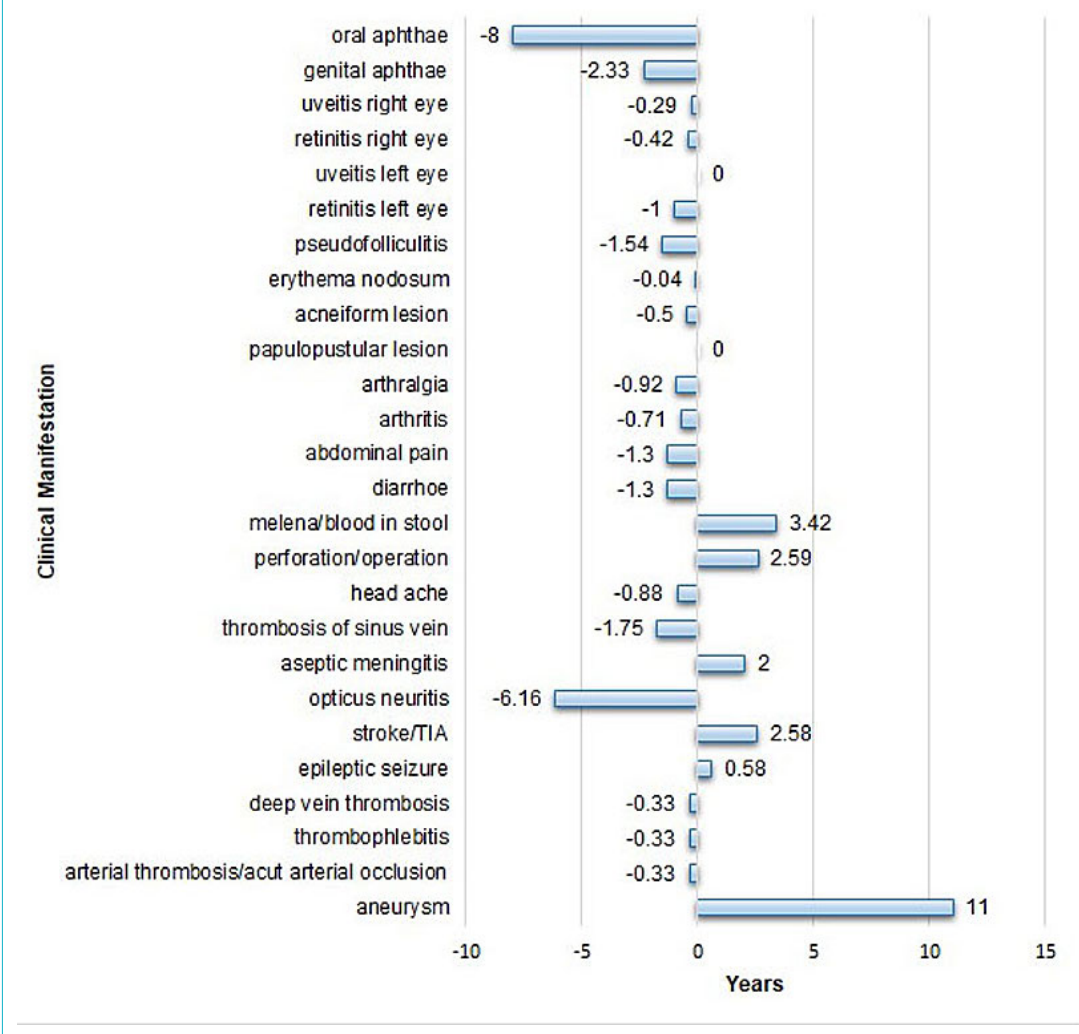
Figure 2: Time (in years) between diagnosis (0) and occurrence of disease manifestation. Negative values represent the delay of diagnosis after occurrence of disease manifestation; positive values indicate the occurrence of manifestation after diagnosis. Values represent the medi- an time between diagnosis and the respective disease